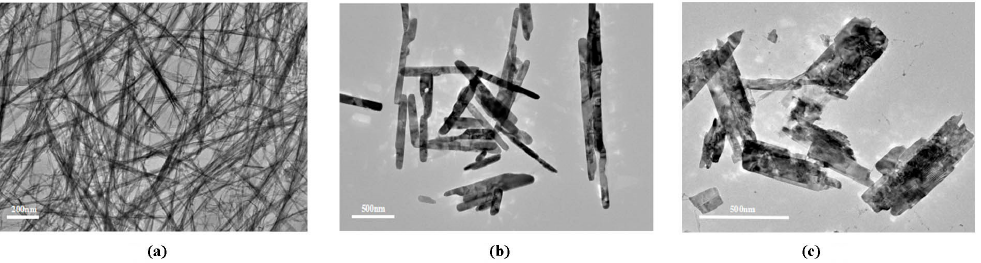
Figure 1. TEM images of VO 2 nanoparticles. ( a ) VO 2 nanofibers ( b ) VO 2 nanosheets ( c ) VO 2 nanorods.